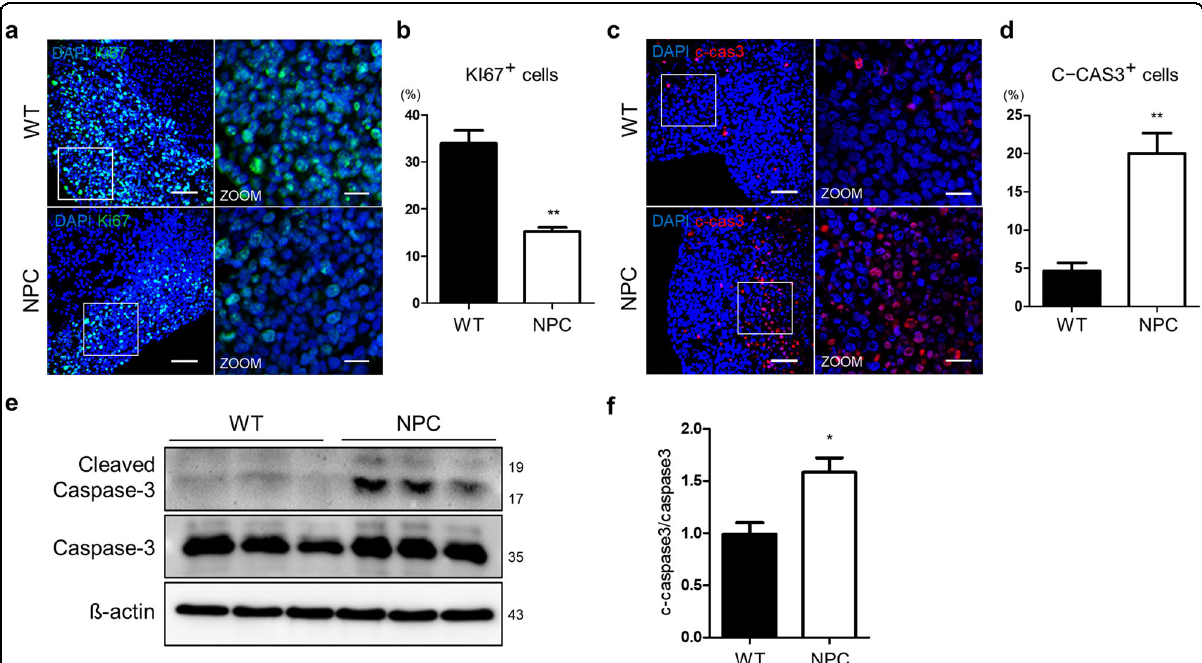
Fig. 3 NPC organoids showed decreased proliferation. Comparison of cellular proliferation and apoptosis in the WT and NPC diseased organoids at day 28. a Immunostaining for cell proliferation in the WT and NPC organoids on day 28 using antibodies against Ki-67. Scale bars, 50 μ m. Zoom scale bars, 10 μ m. b The quanti fi cation of Ki-67-positive cells was conducted following the same method used in Fig. 2d. c The WT and NPC organoids were stained on day 28 for the apoptosis marker cleaved-caspase-3. Scale bars, 50 μ m. Zoom scale bars, 10 μ m. d The percentage of cleaved-caspase-3-positive cells was upregulated in the NPC organoids compared with the WT organoids. e Western blot analysis and f quanti fi cation of cleaved-caspase-3 revealed an increase in the NPC disease organoids at day 28. n = 3 per group. The results are the mean ± SD. n = 3 per group. * p < 0.05, ** p < 0.01, and *** p <